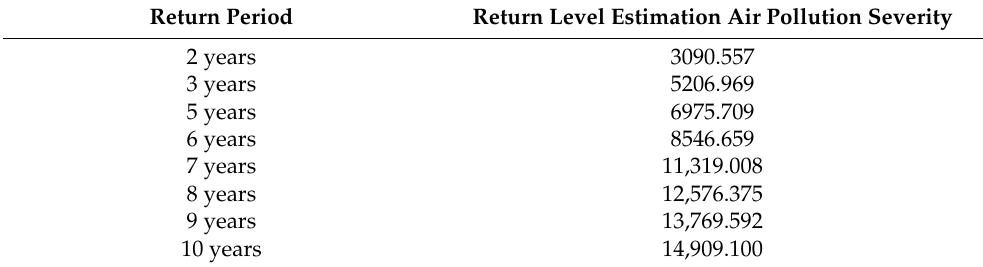
Figure 9. Return level estimates based on the GMLE and L ‐ moment approaches. Table 4. Return level estimates corresponding to their return